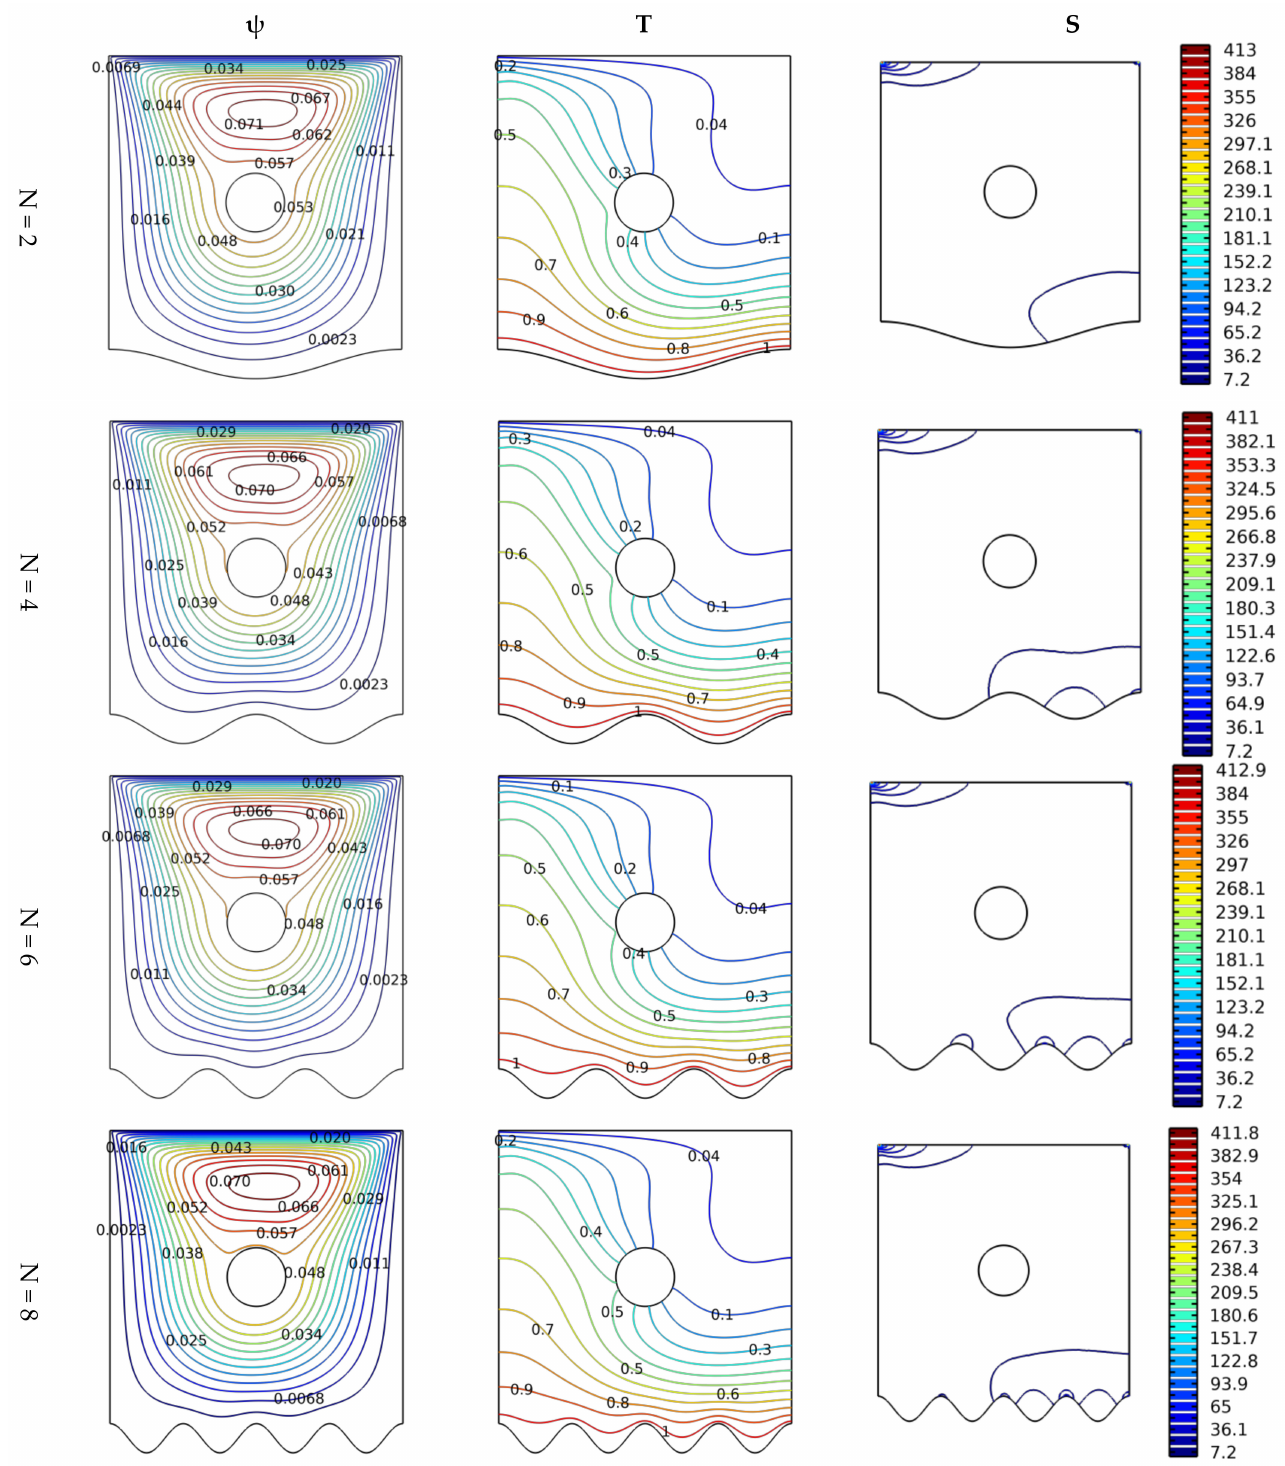
Figure 3. Distribution of streamlines, isotherms, and isentropic contours for various undulation numbers N at Gr = 10 3 , Ha = 0, and Da = 10 − 2